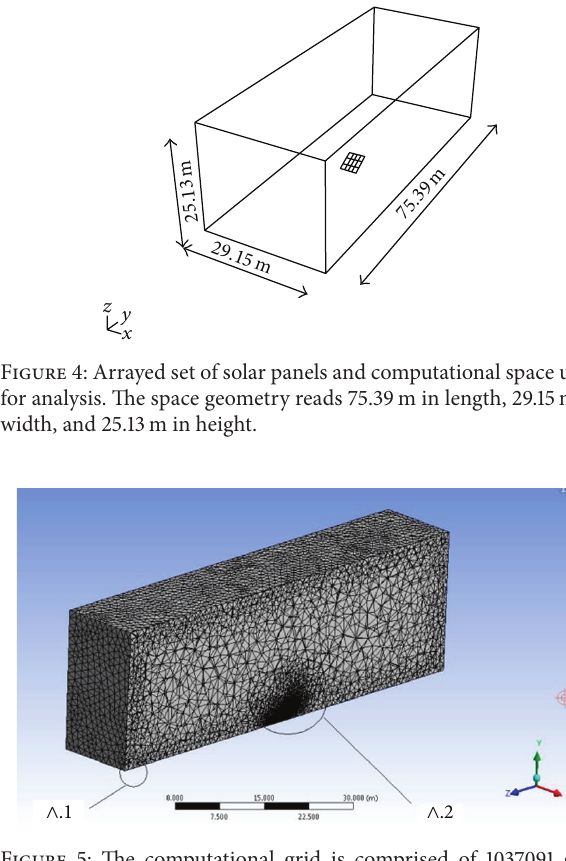
𝑢 𝑖 are the velocity components in pressure; 𝑔 𝑖 is the gravity acceleration along the 𝑖 -axis; 𝐹 𝑖 are the applied external forces; 𝜇 is the molecular viscosity; 𝛿 𝑖𝑗 is the Kronecker symbol; and 𝜏 𝑖𝑗 are the Reynolds stresses.